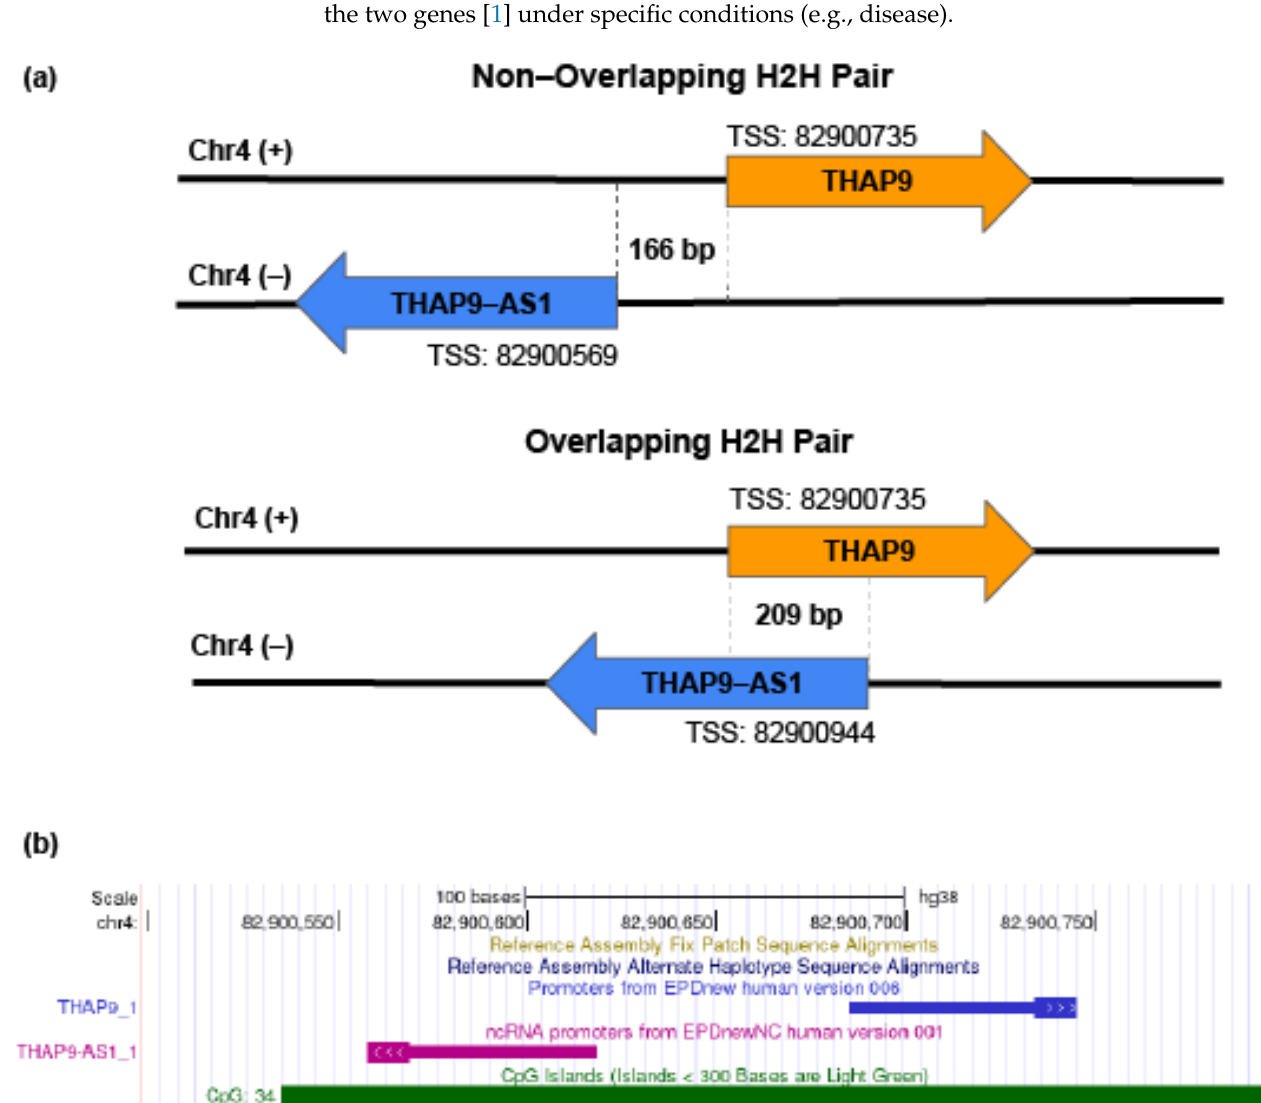
Figure 1. Identification of putative bidirectional THAP9/THAP9-AS1 promoter. ( a ) Schematic representation of the bidirectional genomic organization of THAP9 and THAP9-AS1 genes along with the TSS predicted by EPDnew. ( b ) UCSC genome browser showing THAP9 and THAP9-AS1 genes transcribed divergently based on the human GRCh38 assembly. CpG islands overlapping with the bidirectional promoter region are also indicated.